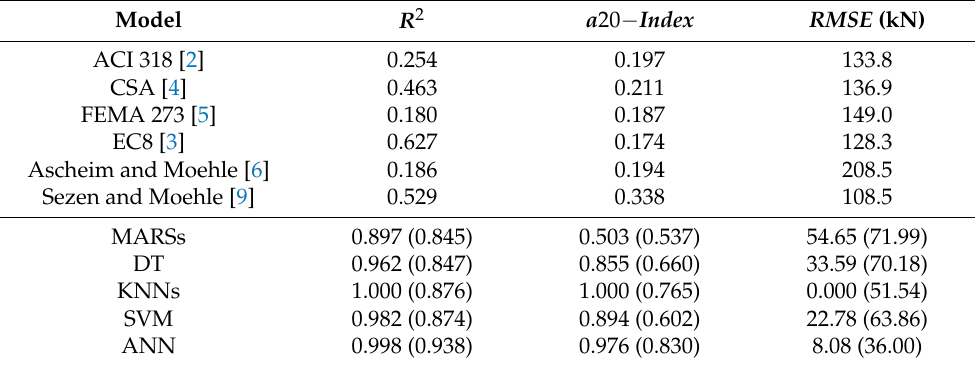
Table 3. Statistical indicators of different predictive models.